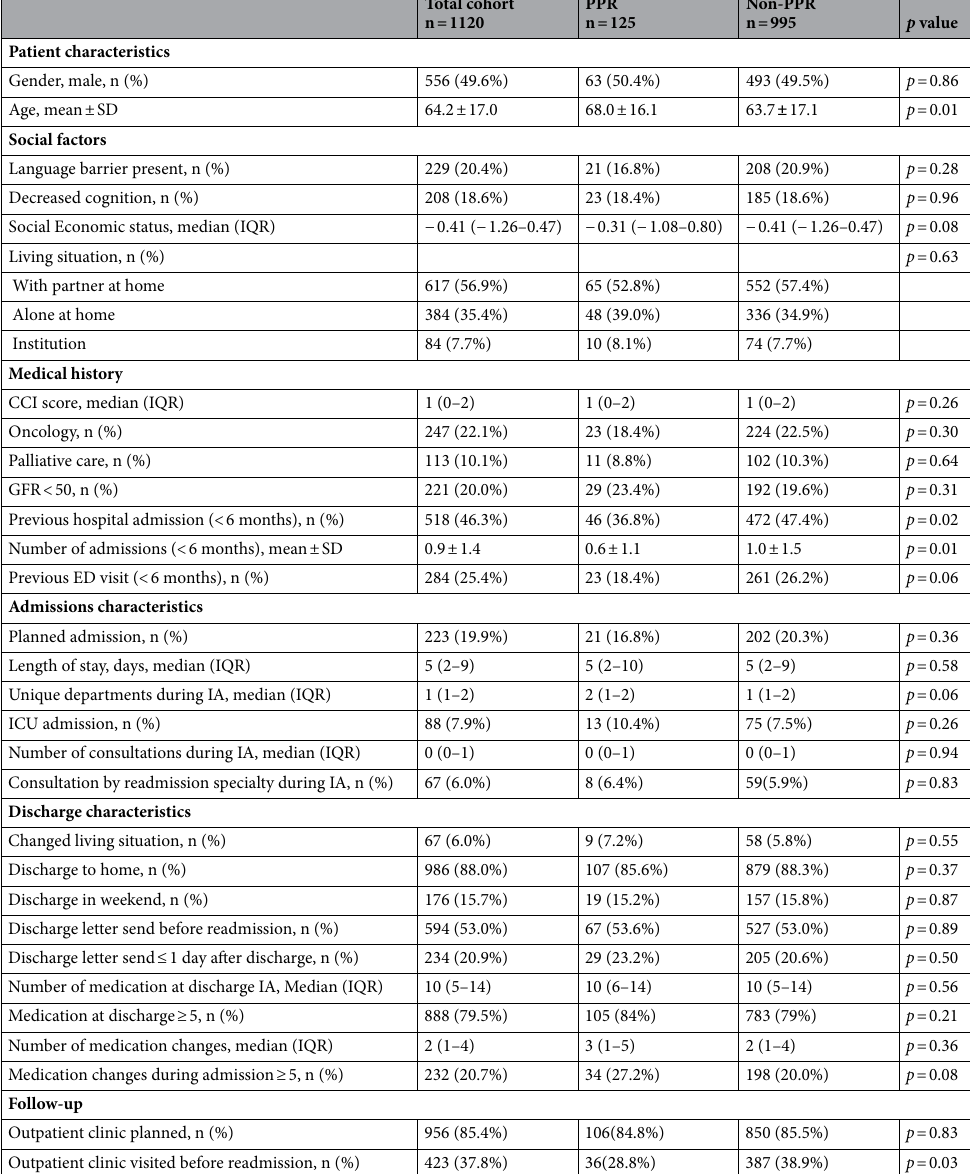
Table 1. Patient demographics and initial admission (IA) characteristics. IA = initial admission, CCI = Charlson Comorbidity index, PPR = potentially preventable